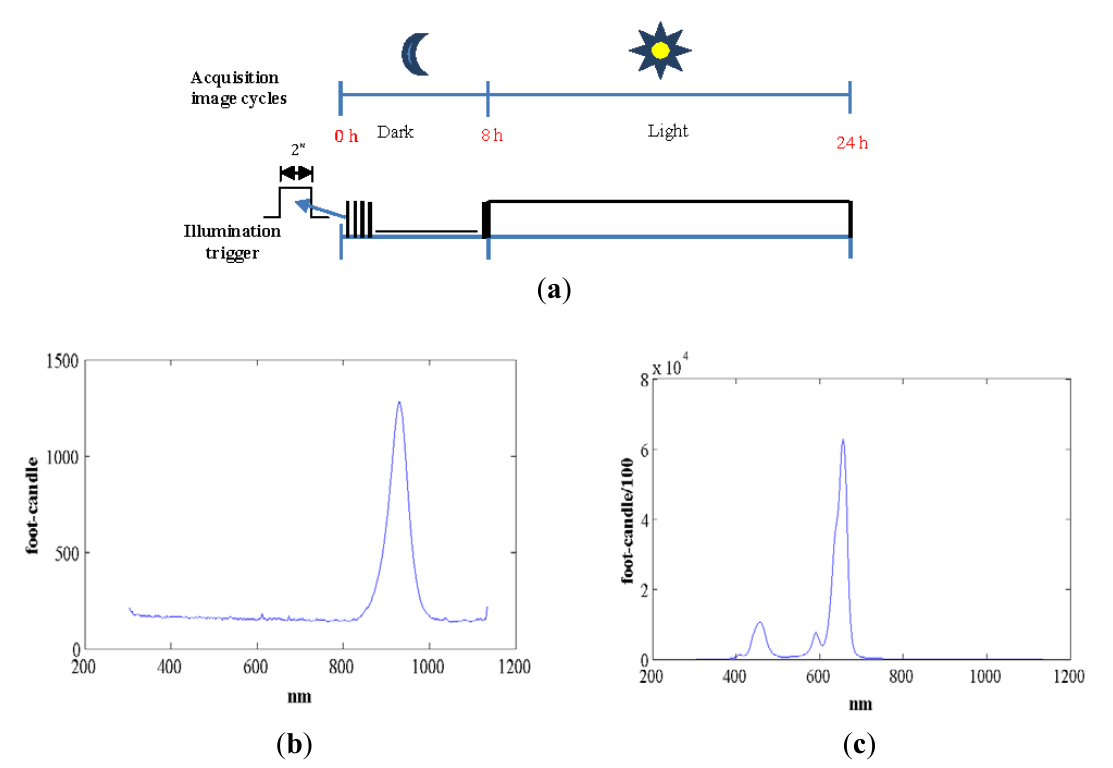
Figure 3. ( a ) Cycling of the illumination system for a circadian period of 8 h dark and 16 h light; ( b ) light spectra for night lighting; and ( c ) light spectra for day